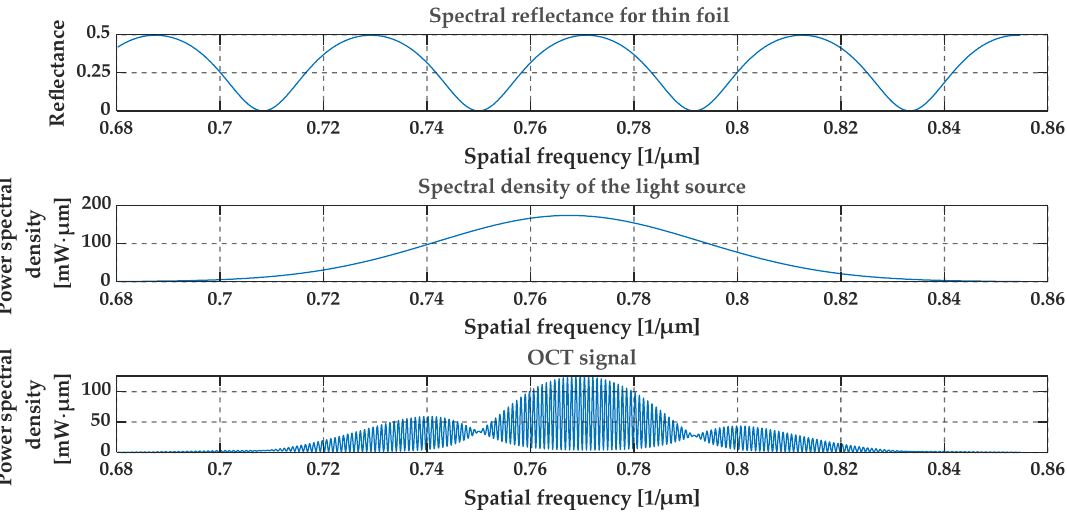
Figure 5. Theoretical spectral characteristics obtained from a thin foil of diamond. The thickness of the foil is 5 µm and the depth of the layer is 0.25 mm. Refractive indexes are n 1 = 1, n 2 = 2.4, n 3 = 1.